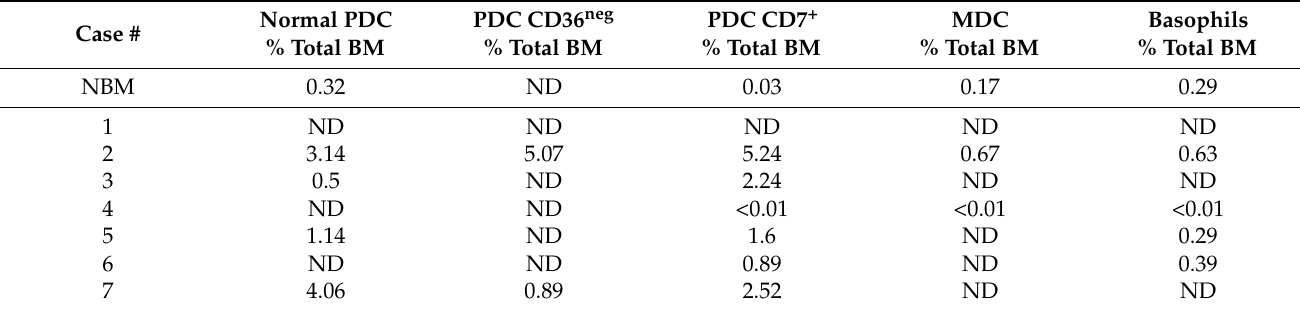
Table 2. Frequency of CD123 + cell subsets in NBM and analyzed patient bone